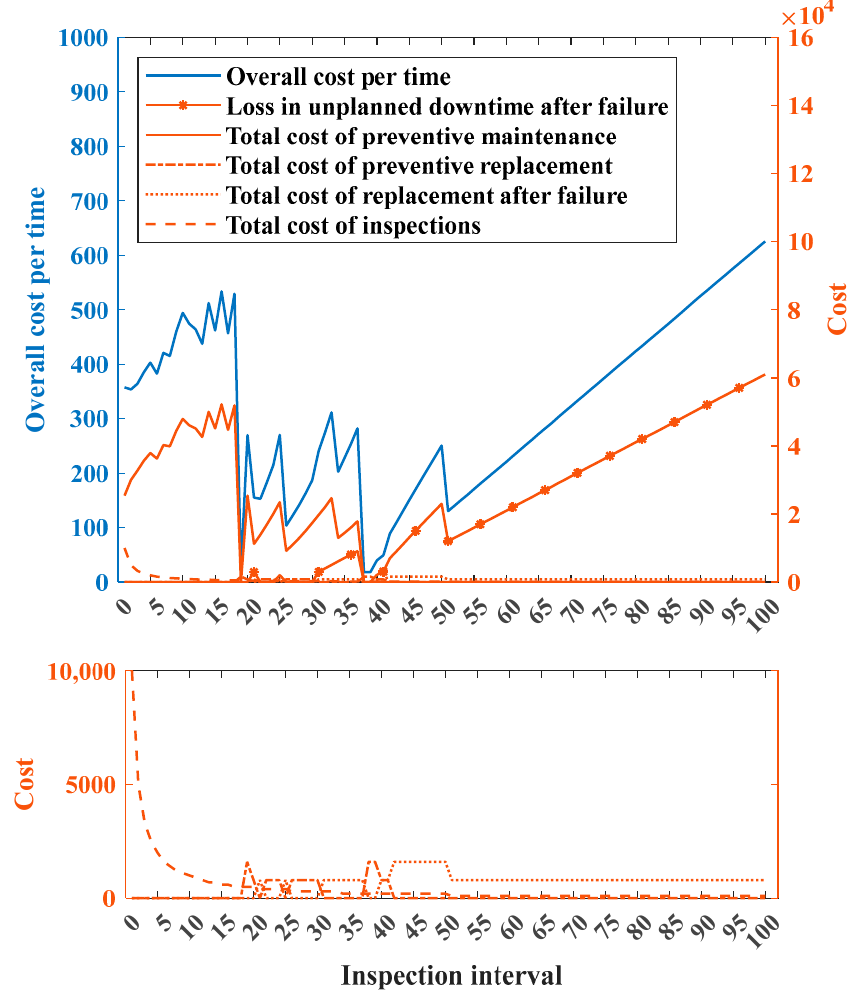
Figure 4. The overall cost per time when different inspection intervals are used.